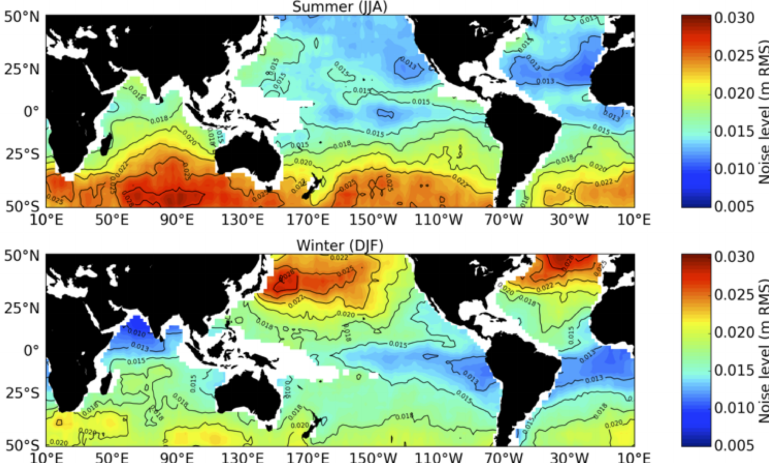
Figure 2. Geographical distribution of the 1 Hz noise level over the global oceans in: ( upper panel ) June–August; and ( lower panel ) December–February. The noise is estimated from wavenumber spectra averaged over 15 ◦ × 15 ◦ boxes, as a constant value fit over the wavelengths 14–30